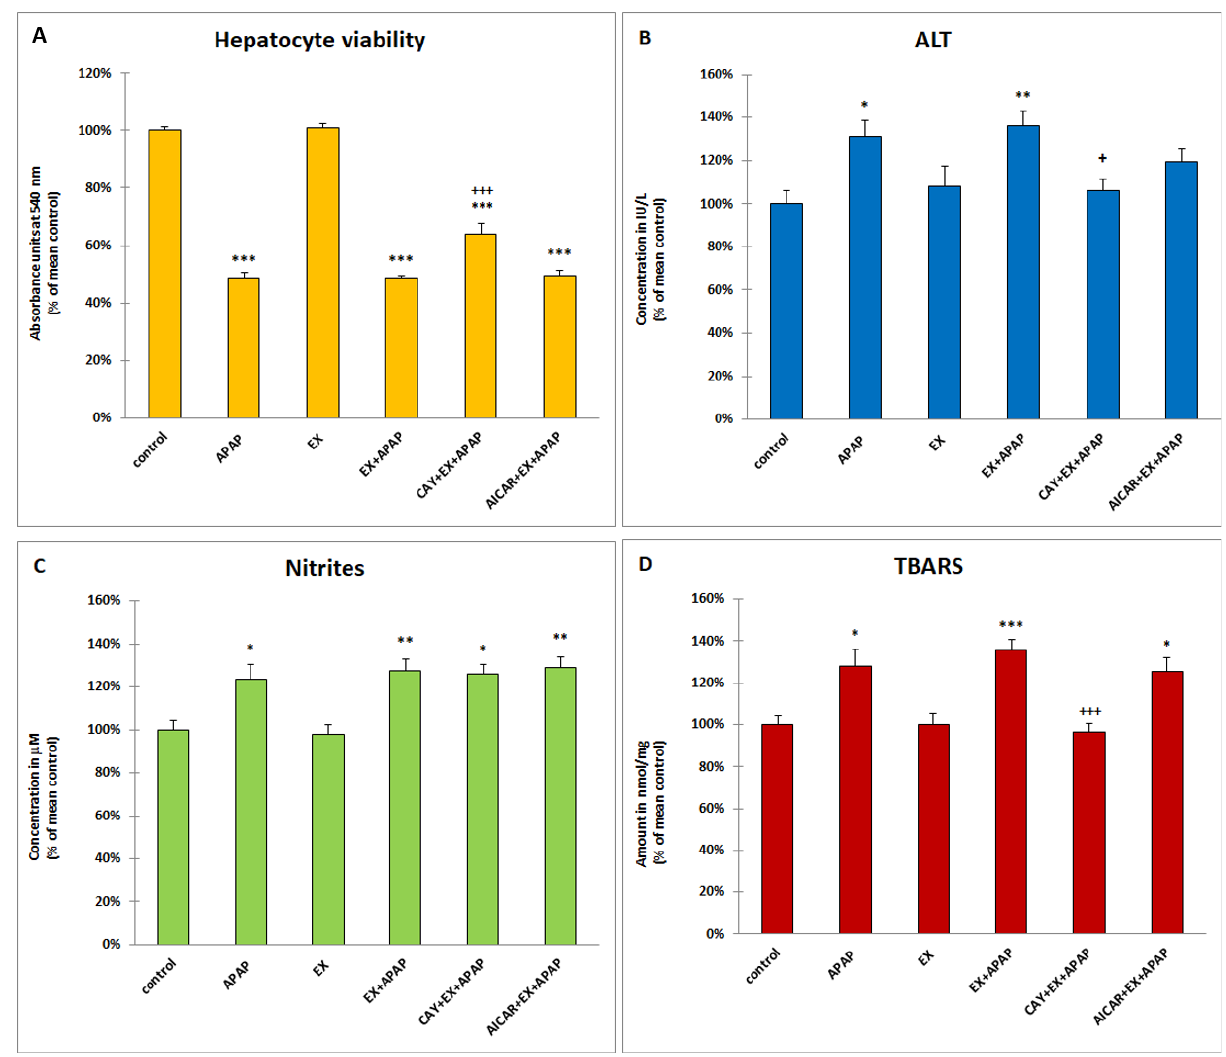
Fig. 2. Effects of specific SIRT1 modulators (activator – CAY10591/CAY and inhibitor – EX-527/EX) and AMPK activator (AICAR) in acetaminophen (APAP)-induced hepatotoxicity on A. hepatocyte viability, B. alanine aminotransferase (ALT) release, C. nitrite (NO 2- ) production, D. thiobarbituric acid reactive substances (TBARS) formation in in vitro experiments after 24 h. Data are expressed as means ± SEM (n=9-16): * P <0.05; ** P <0.01; *** P <0.001 vs. respective control; + P <0.05; +++ P <0.001 vs. EX+APAP